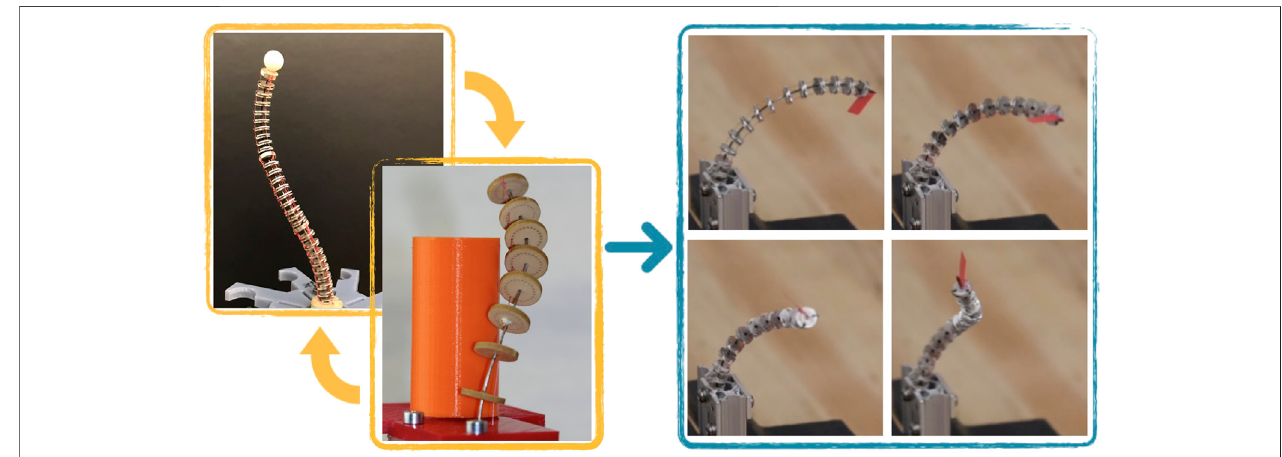
FIGURE 1 | Envisioned tendon-driven continuum robot (on the right) as combination of extensible segment TDCR [top left, from (Amanov et al., 2019)] and TDCR with helical routing [bottom left, from (Starke et al., 2017)].